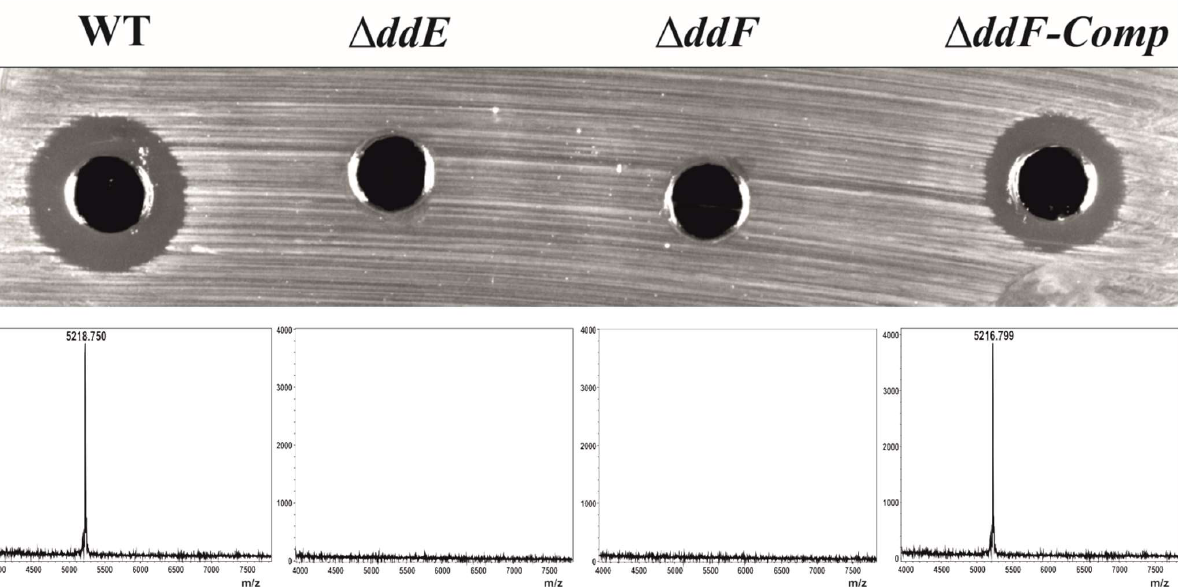
Figure 2. Production of the EntDD14 by E. faecalis 14 WT and its derivative mutant strains. ( A ) Agar diffusion test of cell-free supernatants against L. innocua ATCC 33090. The inhibition halo indicates DD14 production. ( B ) Detection of the EntDD14 purified from bacterial supernatants by matrix-assisted laser desorption ionization time-of-flight mass spectrometry (MALDI-TOF/MS).